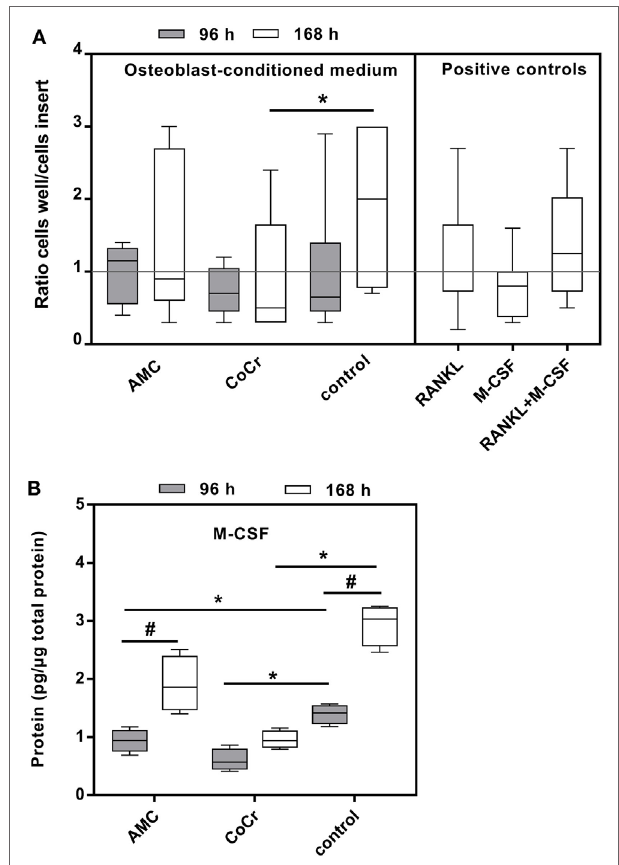
FigUre 8 | Osteoblast-conditioned medium: influence on migration of human monocytes (a) and M-CSF protein content (B) . (a) Cells were treated with 96 and 168 h osteoblast-conditioned medium and growth factor controls (positive controls) for 18 h. Cells in insert and well were counted and ratios calculated. Data are shown as box plots of ratios ( n = 6) normalized to the negative control. Significances between groups were calculated with Friedman test with Dunn’s post-test (* p < 0.05). (B) Cell culture supernatants were used to evaluate the concentration of M-CSF (per total protein content). Data are shown as box plots (n = 4). Significances between groups were calculated with the Mann–Whitney U- test (* p < 0.05, treated vs. untreated; # p < 0.05, 96 vs. 168